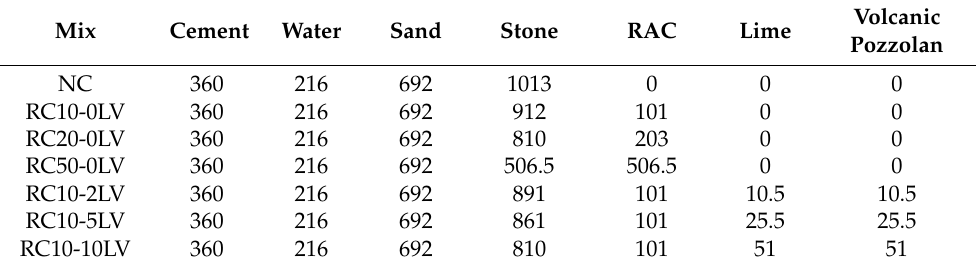
Table 5. Mix proportions of RAC mixtures (kg/m 3 ).